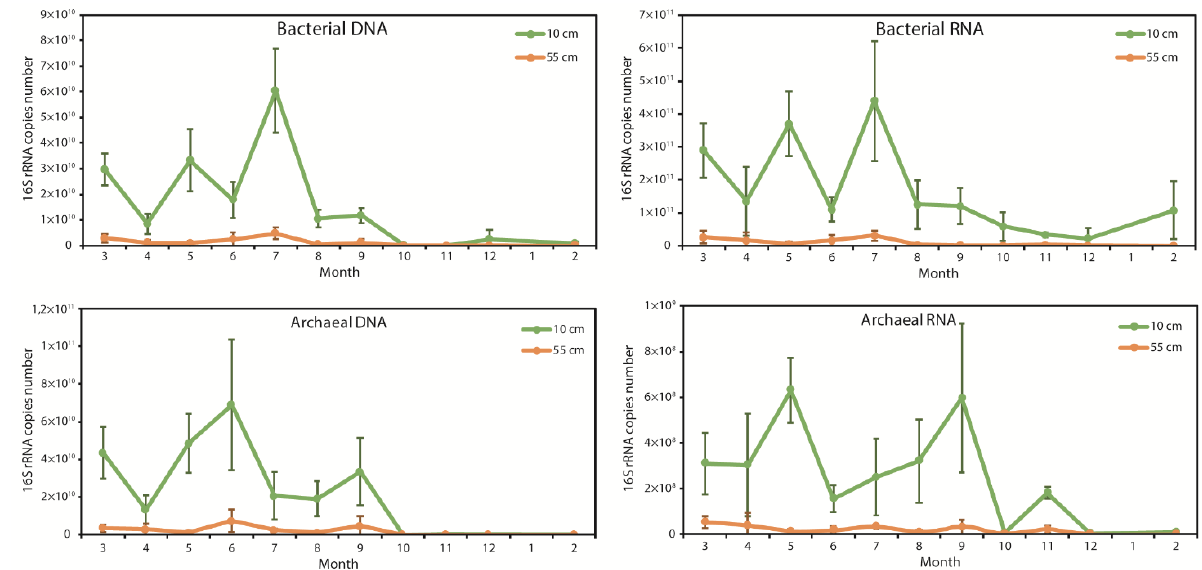
Figure 3. Seasonal dynamics of bacterial and archaeal 16S gene (DNA) and gene transcript (cDNA) copy numbers in soil (10 cm is the sampling depth for upper organic horizon, 55 cm is the sampling depth for lower mineral horizon).